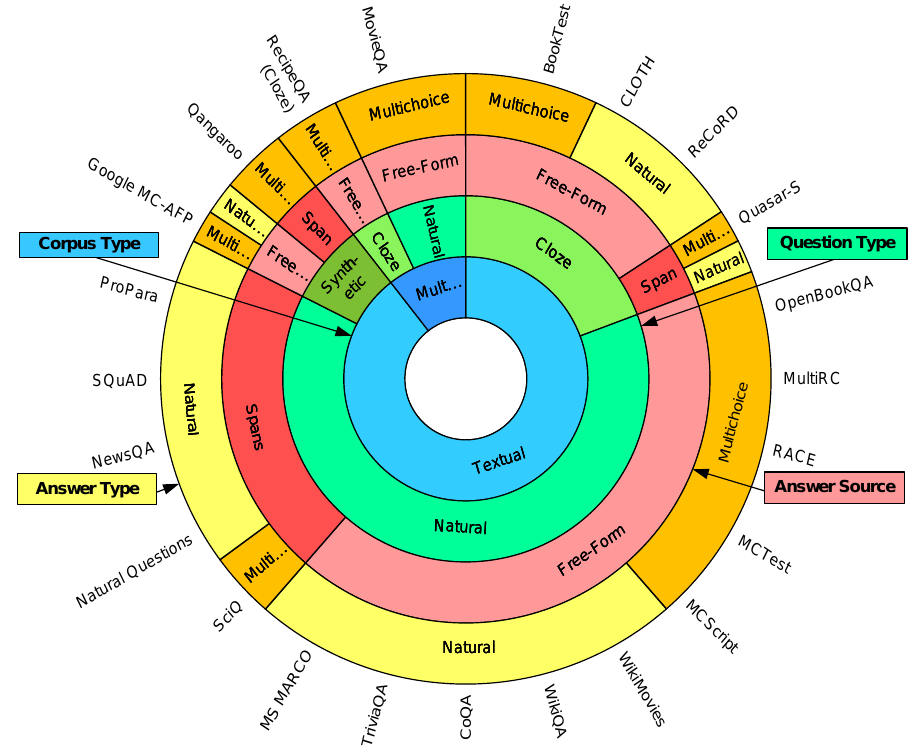
Figure 10. A sunburst chart on the proportion of different types of machine reading comprehension